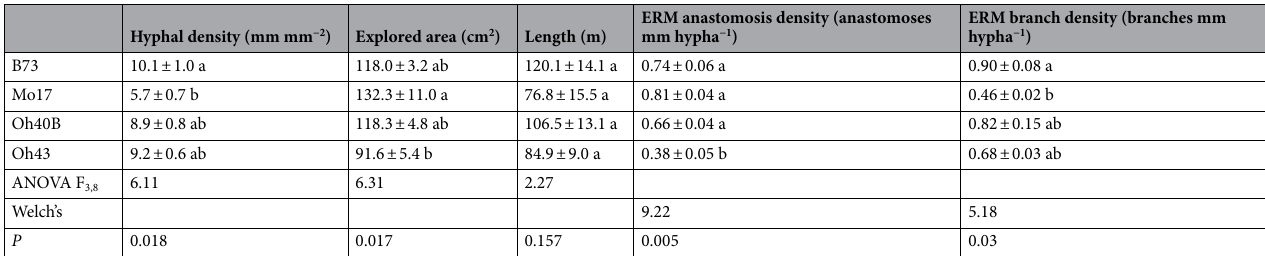
Table 2. Phenotypic traits (mean ± standard error of the mean) of extraradical mycelium (ERM) formed by Rhizoglomus irregulare in symbiosis with four Zea mays inbred lines, under low phosphorus (P) availability (0.47 mg kg −1 ). For each trait, F and P values resulting from one-way ANOVA, or Welch’s test for unequal variances, are reported. In columns, values followed by the same letter do not differ significantly at P ≤ 0.05 by Tukey’s HSD or Tamhane T2 test.